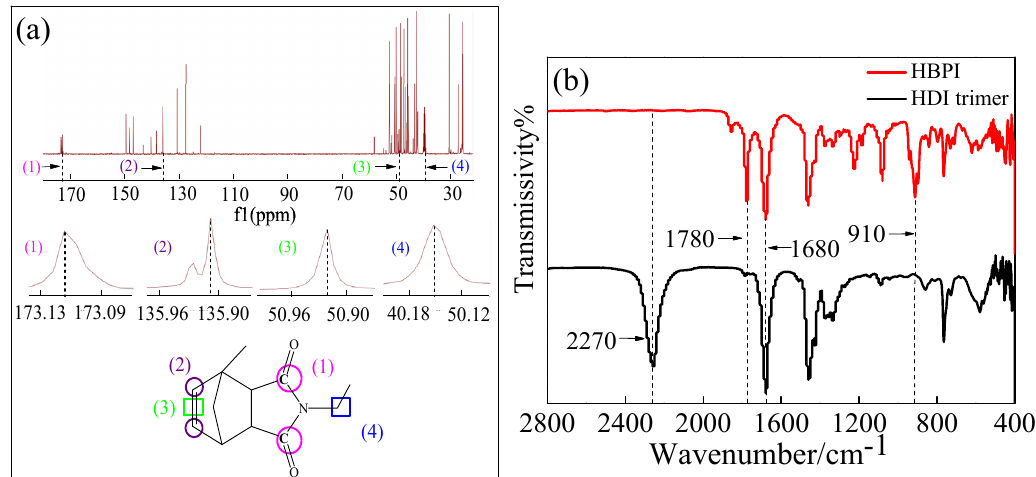
Figure 3. ( a ) 13 C-NMR characterization of HBPI, ( b ) FT-IR characterization of HBPI and HDI trimer.